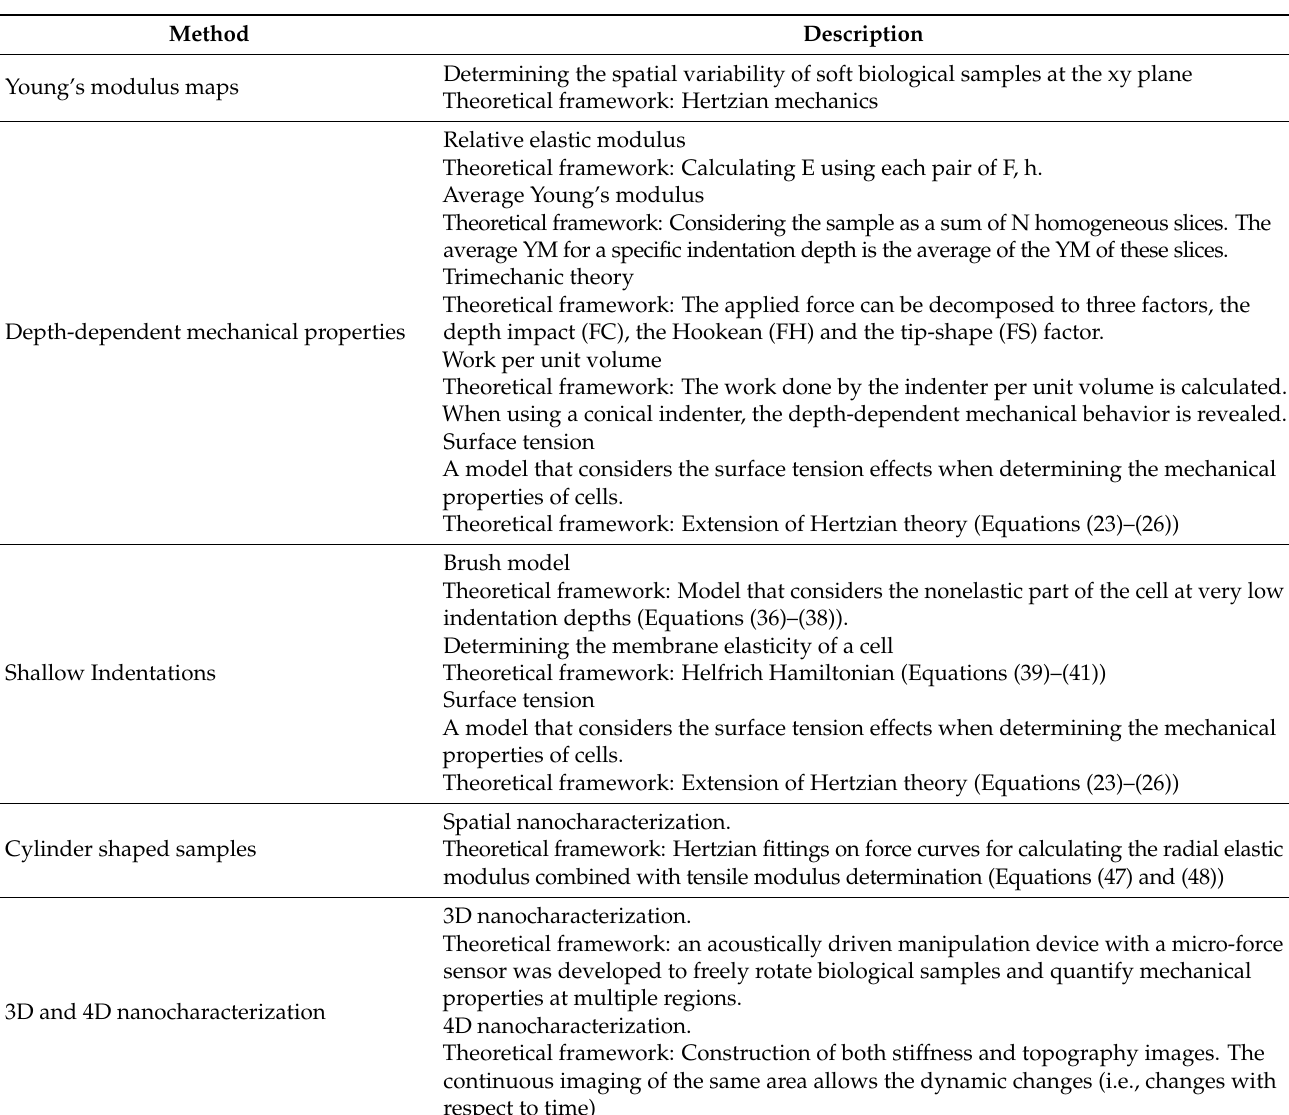
Table 1. Methods for determining spatial variability of bio-samples elastic